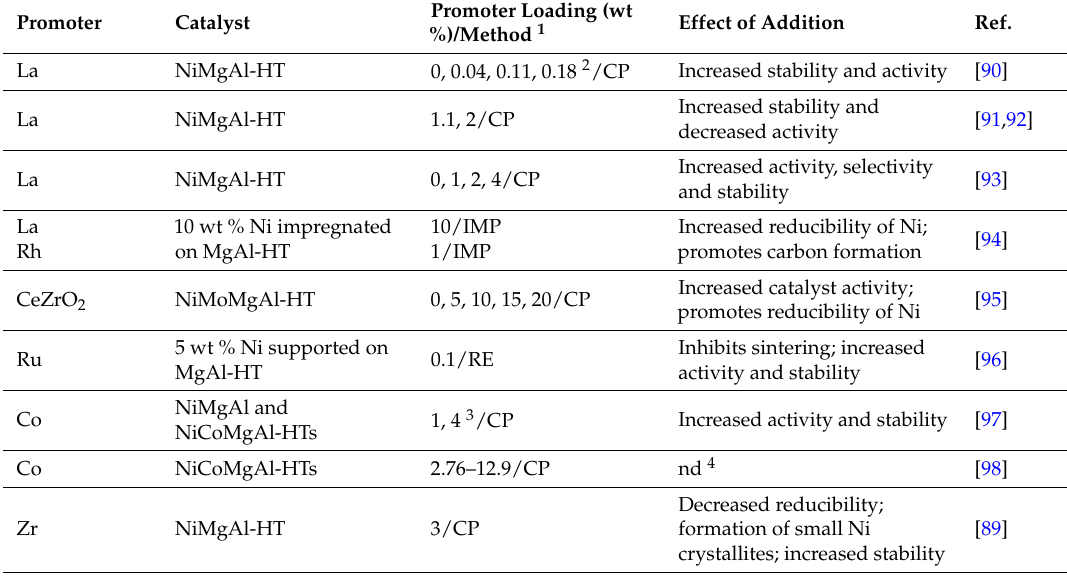
Table 5. Effect of different promoters on the performance of NiMgAl hydrotalcite-derived catalysts for